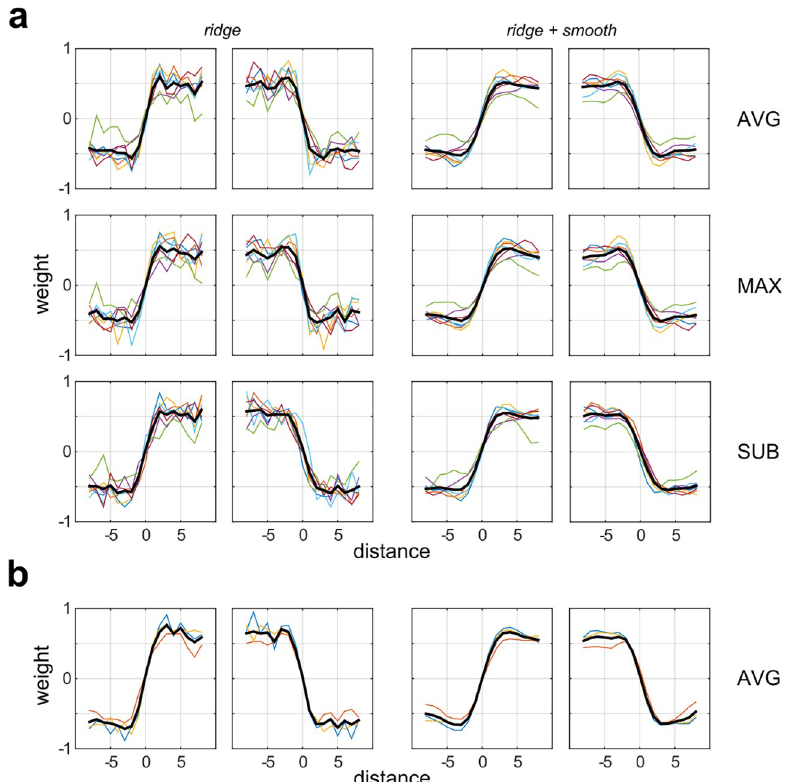
Fig 4. 1-D profiles of the second-stage filter weights for all observers in Experiment 1. (a) 1-D profiles for individual observers in Experiment1-VAR (colored lines) plotted with the average across observers (thick black lines) for three sampling rules (AVG, MAX, SUB) and both priors. (b) Same as (a) but for Experiment